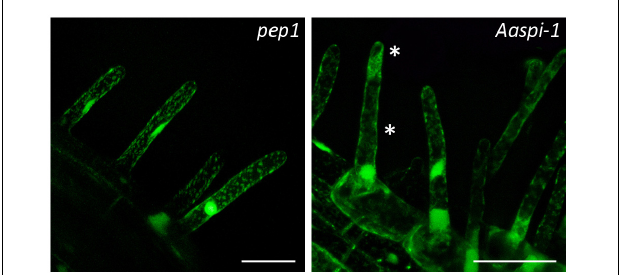
FIGURE 3 | Fragmented root hair vacuoles in pep1 and Aaspi-1 mutants. Left: Representative picture of an intact vacuole in pep1 . Right: Representative picture of a fragmented vacuole in Aaspi-1 . Asterisks indicate fragmented vacuoles. Root hairs were stained with FDA and integrity of vacuoles was analyzed in > 100 root hairs per line. Scale bars: 50 µ m.